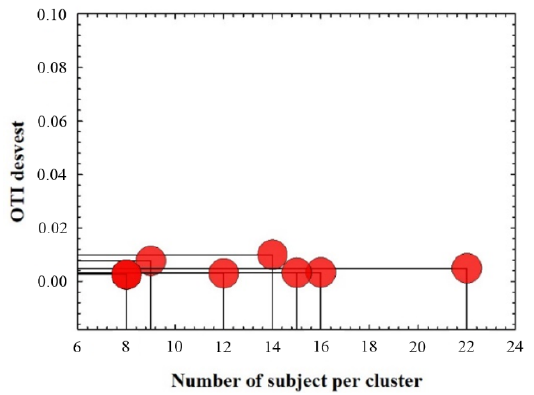
Figure 4. Standard deviation of OTI values as a function of the number of subjects per cluster.